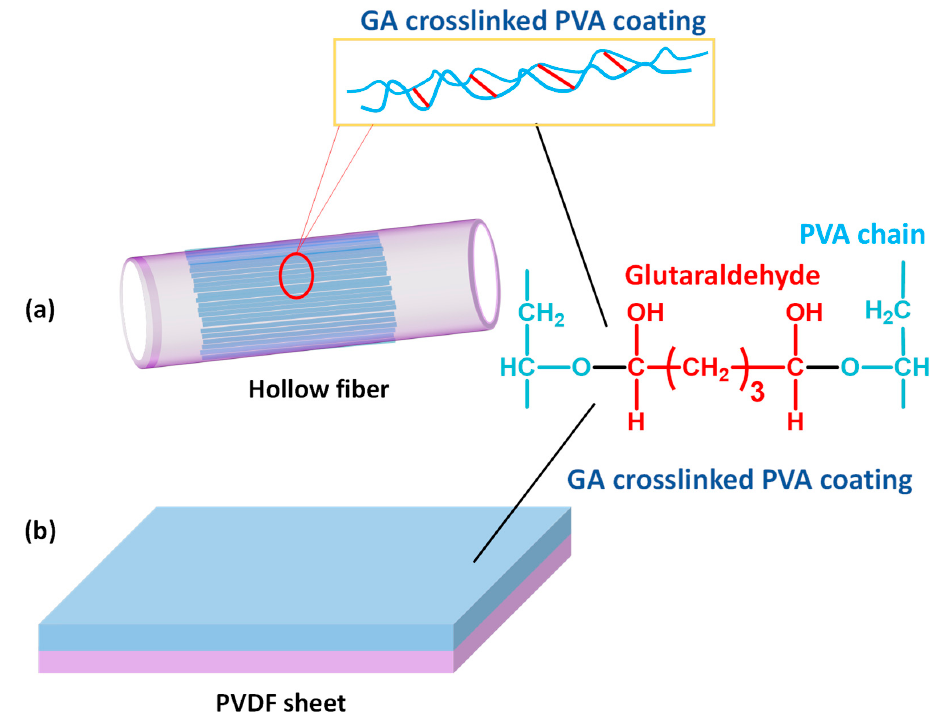
Figure 9. GA crosslinked PVA-coated PVDF membranes prepared by ( a ) dip coating and ( b ) cast coating.